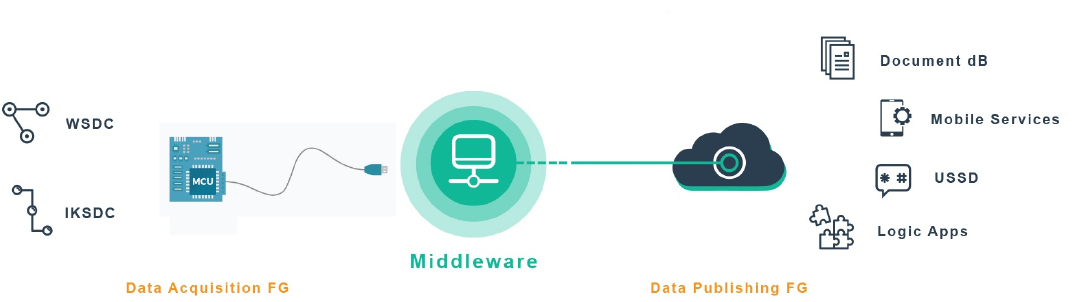
Figure 1. Overview of the distributed